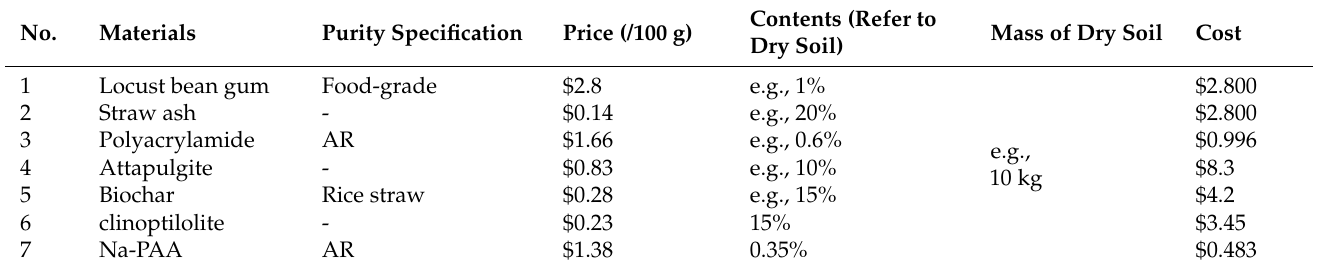
Table 7. Comparison of economic benefits of partial water-retaining agents.